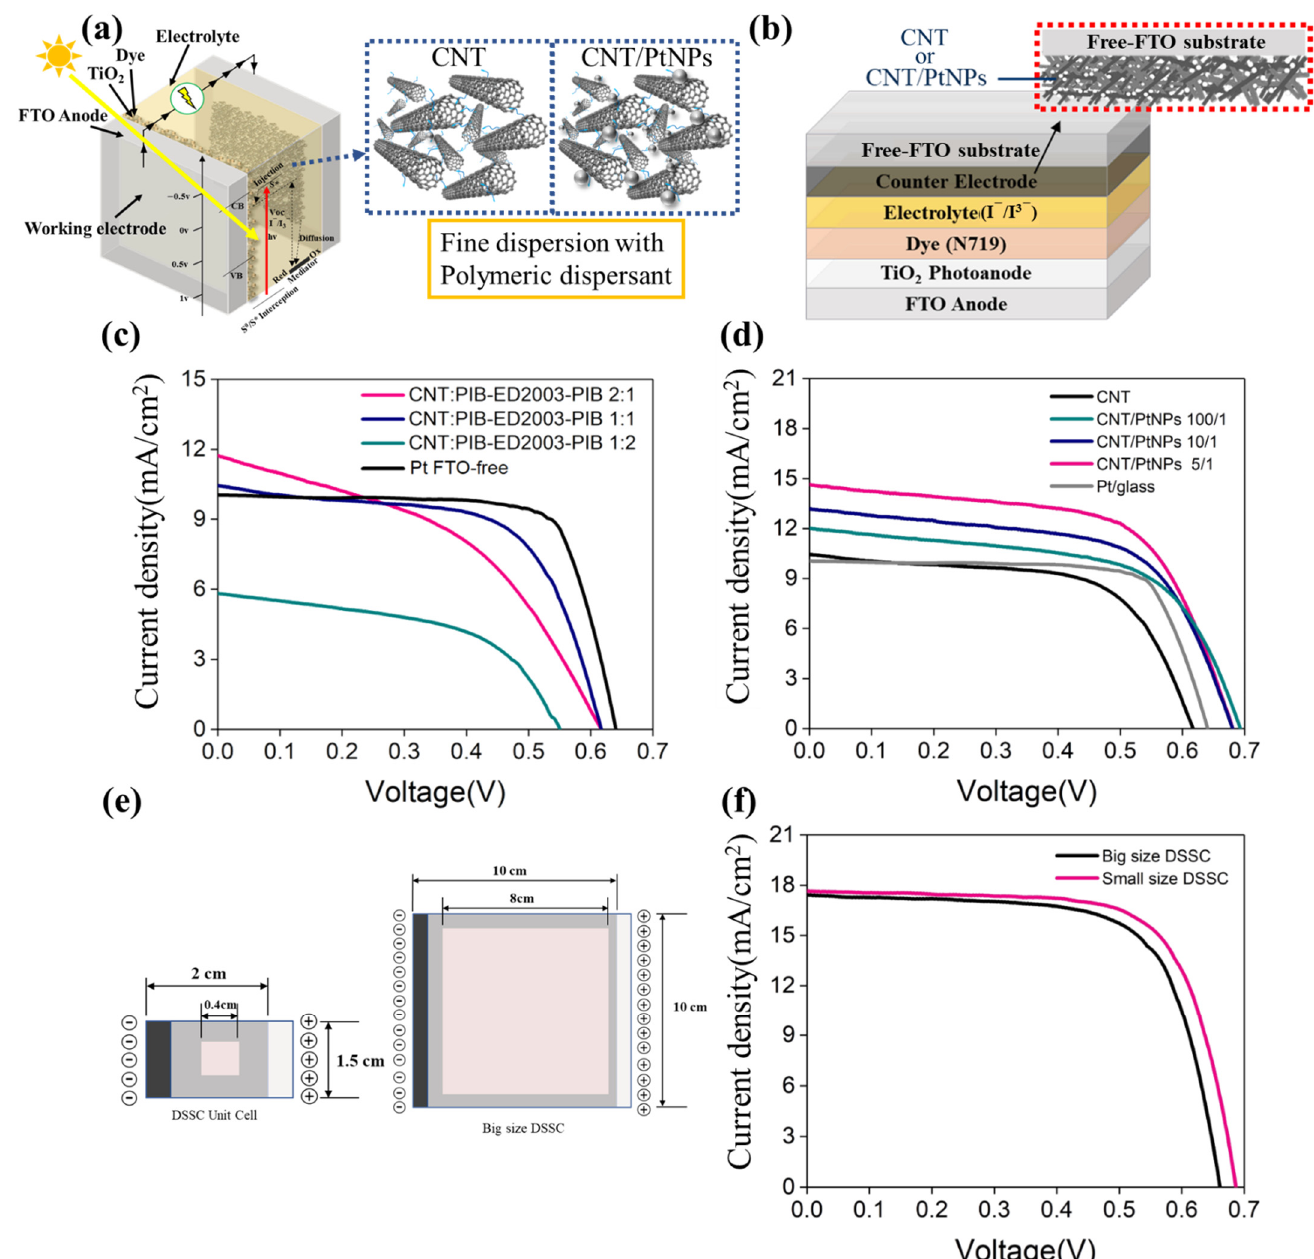
Figure 4. ( a ) DSSC packaging schematic. ( b ) DSSC cross-sectional view. ( c ) Specification diagrams of small-scale and large-scale DSSCs. ( d ) J–V curves of small-scale and large-scale DSSCs. ( e ) Schematic diagrams of small-scale (0.4 cm × 0.4 cm) and large-scale (8 cm × 8 cm) DSSCs. ( f ) Photoelectric conversion efficiencies of small-scale (0.4 cm × 0.4 cm) and large-scale (8 cm × 8 cm) DSSCs.